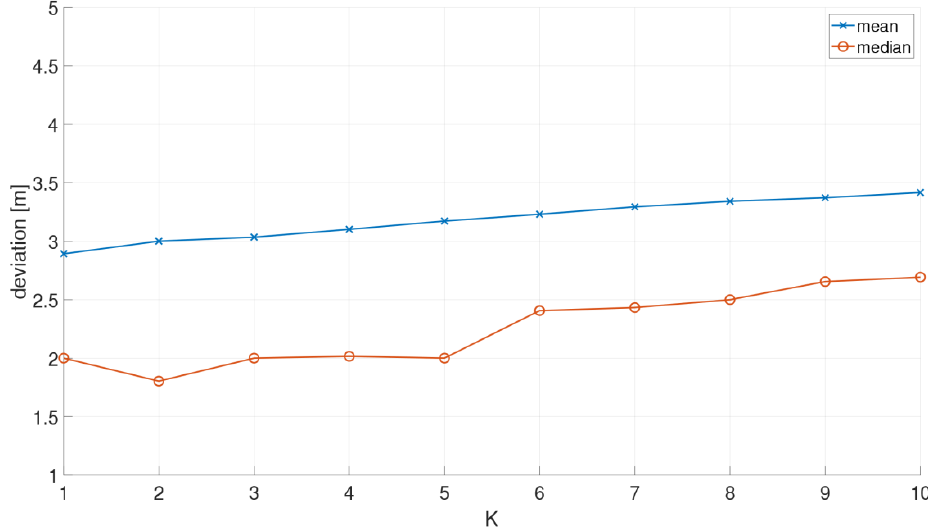
Figure 15. Mean and median deviations for static positioning in dependence of the K value for the nearest neighbor approach.